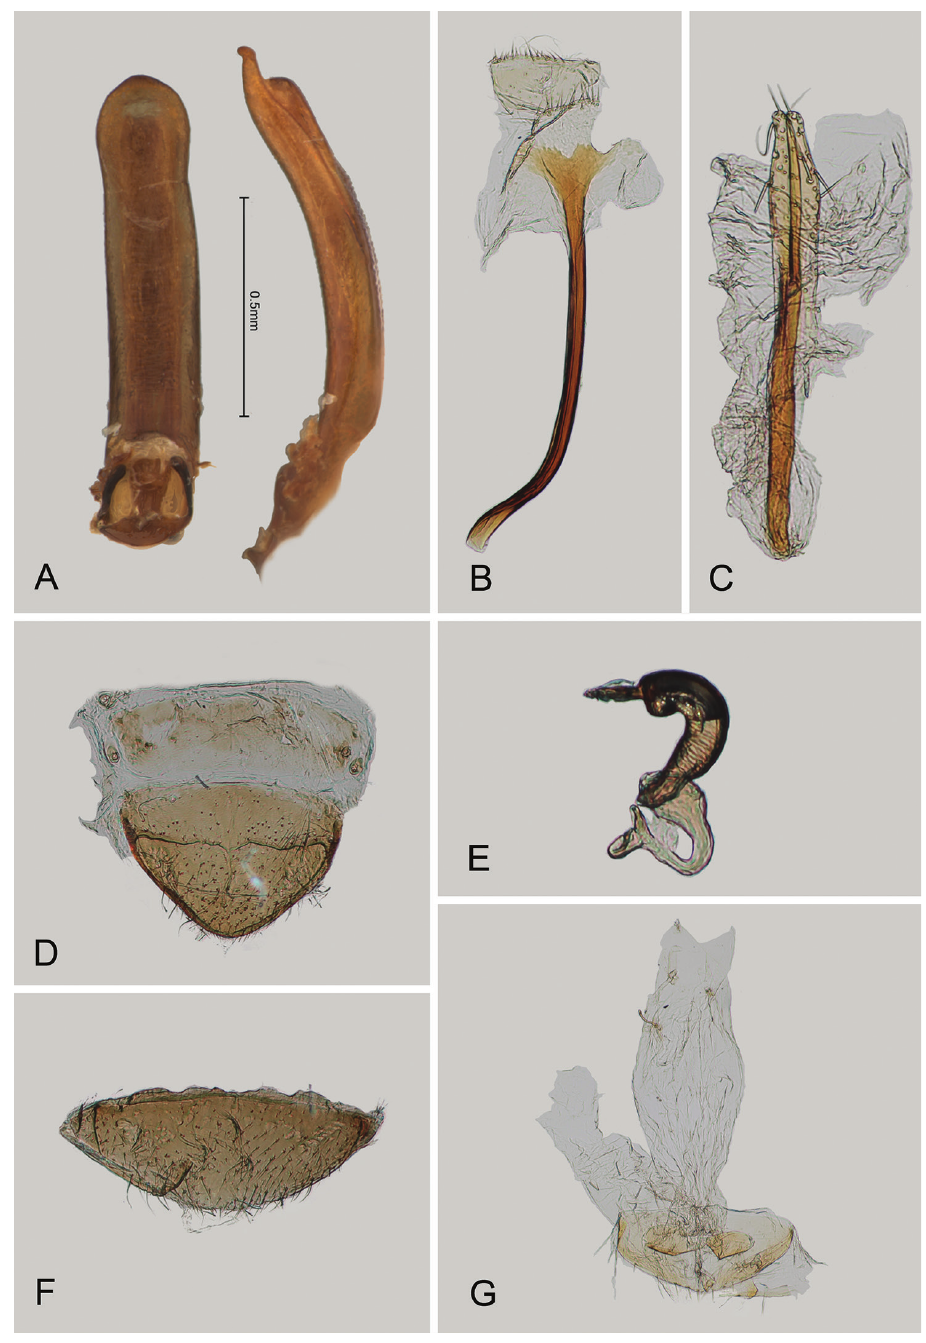
Figure 8. Andersonoplatus castaneus . A Median lobe of aedeagus, ventral and lateral views B Tignum C Vaginal palpi D Last abdominal tergite of female E Spermatheca F Last abdominal sternite of female G Female genitalia, ventral